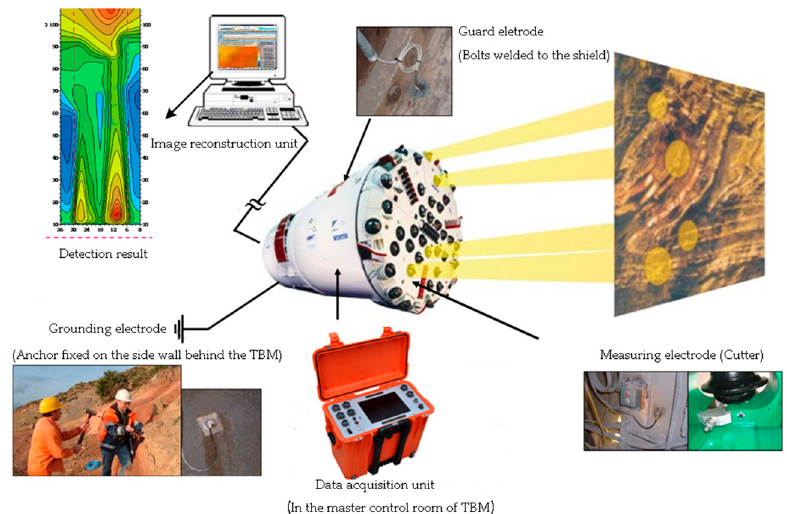
Figure 3. The layout of the coal mine inclined shaft advanced detection system based on the shield cutterhead moving array electrodes.